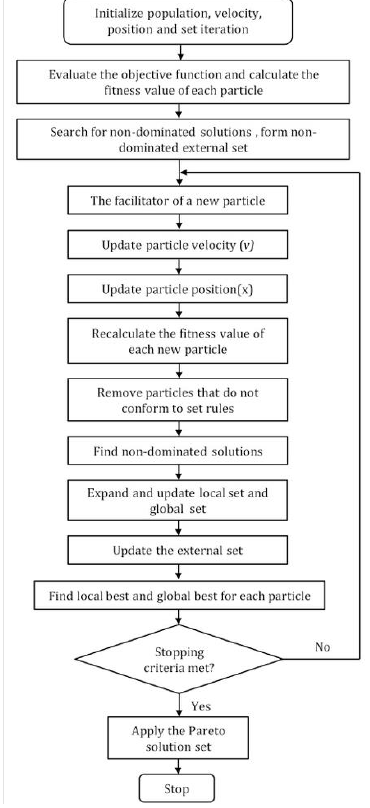
Figure 2. Flowchart of the MOPSO.